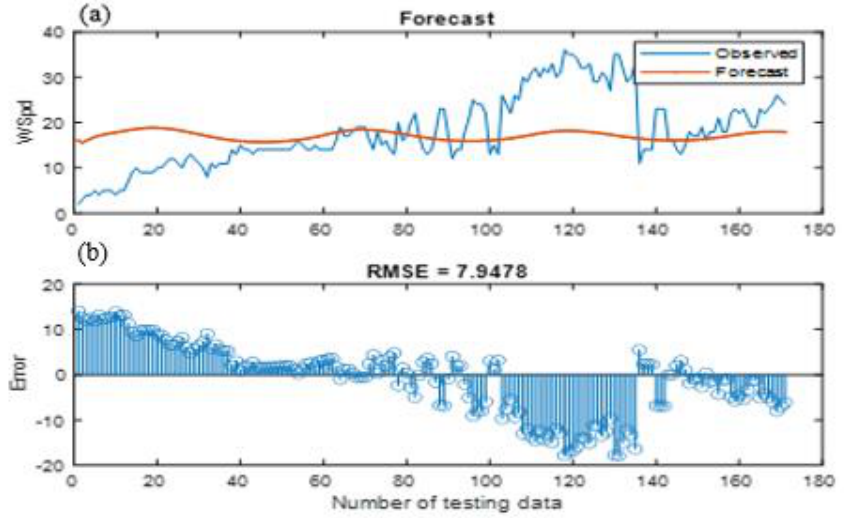
Figure 5. Wind speed prediction of existing LSTM for Summer (July 2015) data: ( a ) Comparison of observed values and forecast values; ( b ) Error and RMSE values.